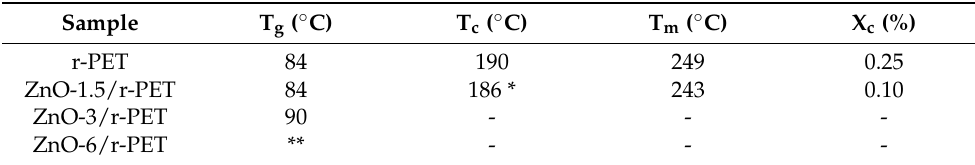
Table 2. Thermal properties of r-PET composite